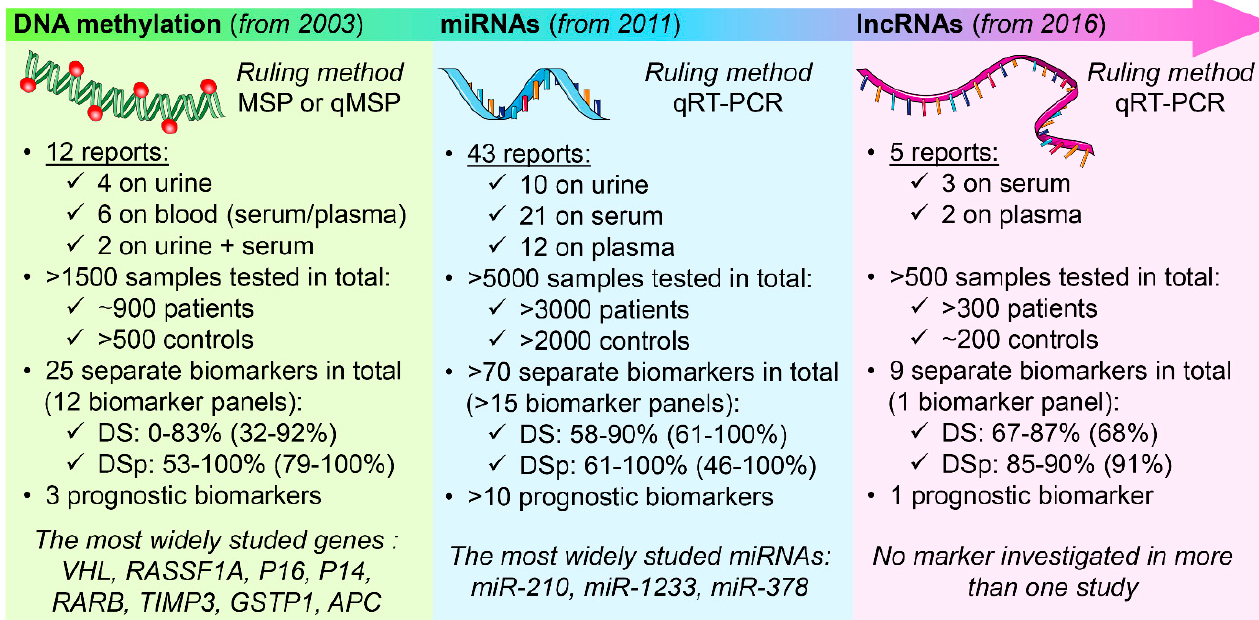
Figure 1. A summary of investigations conducted to date on biofluid circulating epigenetic biomarkers for RCC. This table was created using images from Servier Medical Art Commons Attribution 3.0 Unported License (http://smart.servier.com,